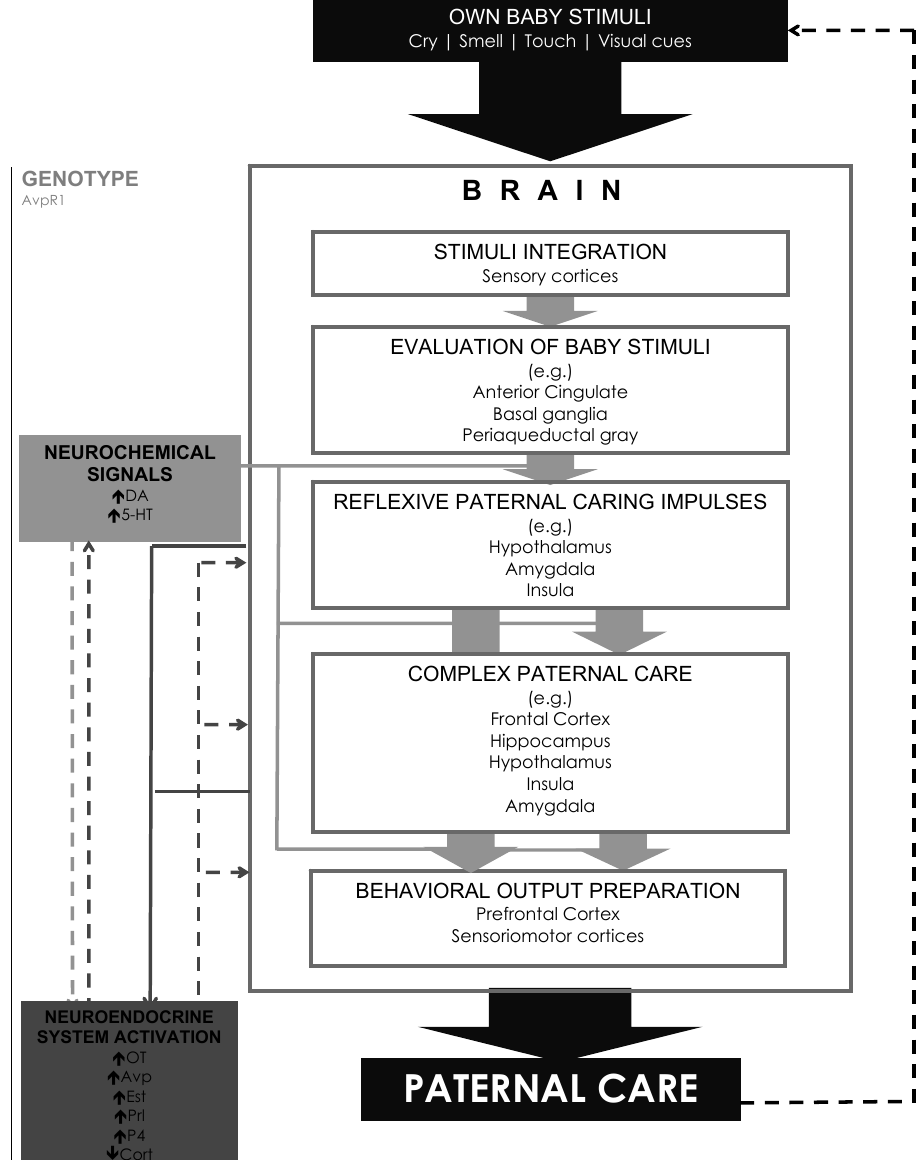
Figure 1. Integrative model of biological bias of paternal